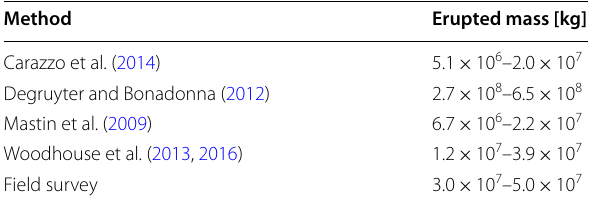
Table 2 Erupted masses estimated using four empirical methods and from a field survey